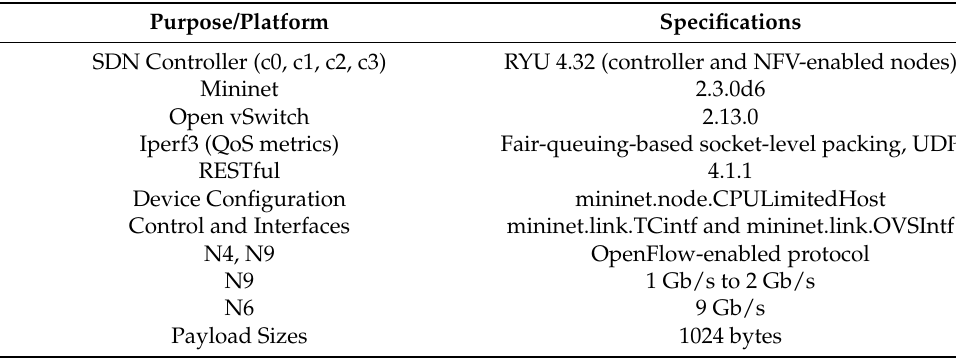
Table 3. Software-defined control system